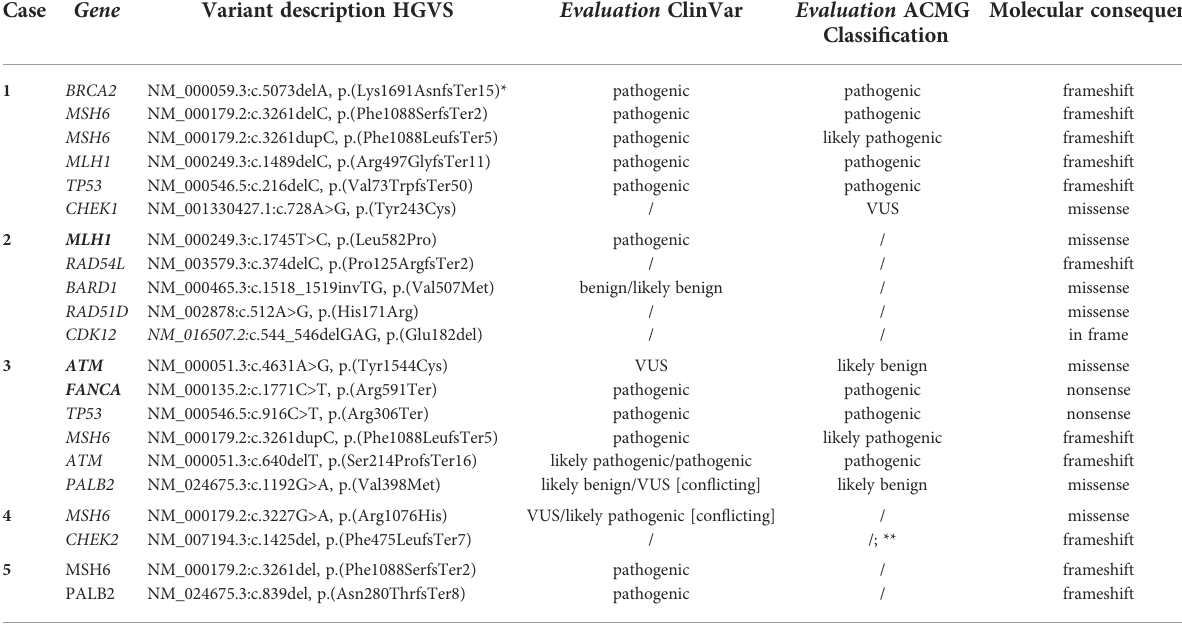
TABLE 3 Detailed overview and signi fi cance of MMR/HRR variants observed in MLH1 - /PMS2 - /MSH6 - digestive system cancer